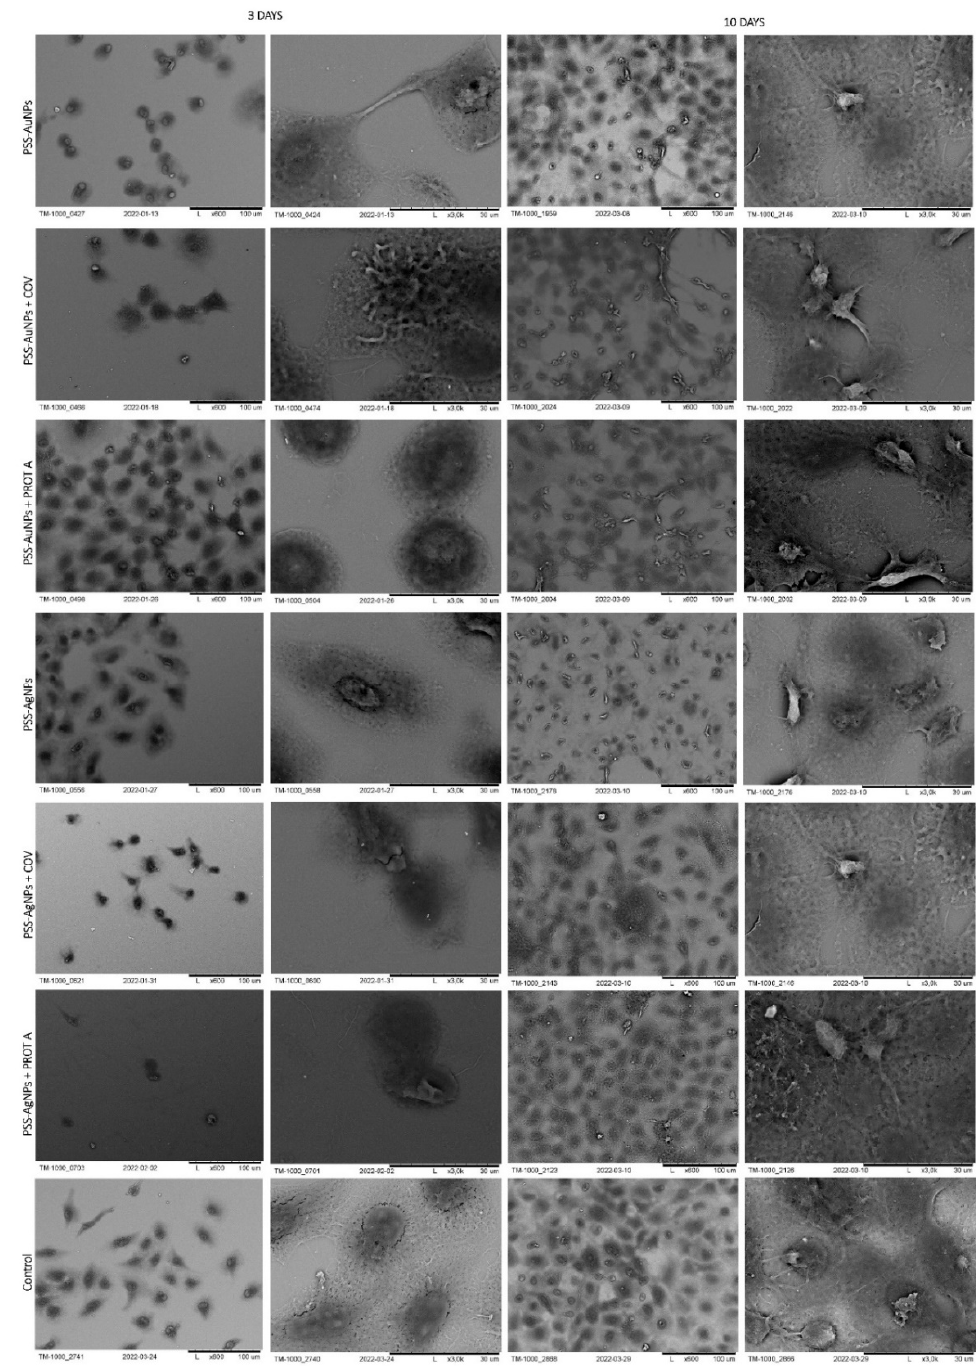
Figure 8. SEM visualization of A549 cells adsorbed within designed membranes after a 3- or 10-day culture. As a control, served cells cultured on glass slides without the membranes. Key to the symbols: PSS-AuNPs: the membrane build of the polystyrene sulfonate with AuNPs incorporated; PSS-AuNPs + COV: the membrane build of the polystyrene sulfonate with AuNPs incorporated with adsorbed COV; PSS-AuNPs + PROT A: the membrane build of the polystyrene sulfonate with AuNPs incorporated with adsorbed Protein A; PSS-AgNPs: the membrane build of the polystyrene sulfonate with AgNPs incorporated; PSS-AgNPs + COV: the membrane build of the polystyrene sulfonate with AgNPs incorporated with adsorbed COV; PSS-AuNPs + PROT A: the membrane build of the polystyrene sulfonate with AgNPs incorporated with adsorbed Protein A.